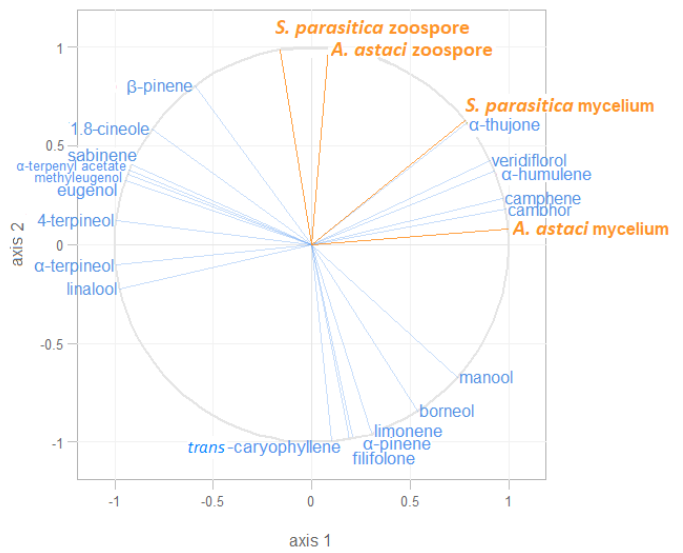
Figure 4. Partial least-squares regression (PLS-R2) radar of correlation. The orange lines represent the EC 50 values for inhibition of mycelial growth and zoospore germination (response variables), while the blue lines represent volatile bioactive compounds present in the essential oils (predictors). Variables placed on the same side of the square within the circle are positively correlated, while those on the opposite side are negatively correlated.